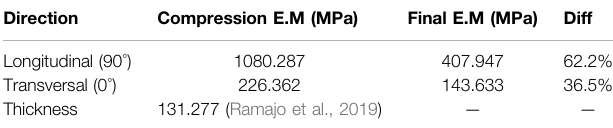
TABLE 3 | The table shows the results compared to the properties previously reported of uniaxial compression tests in the three orthogonal directions compared tothoseobtained fromthetensiletest, both experimental and its fi tting, and the difference obtained between both calculated as percentage relative